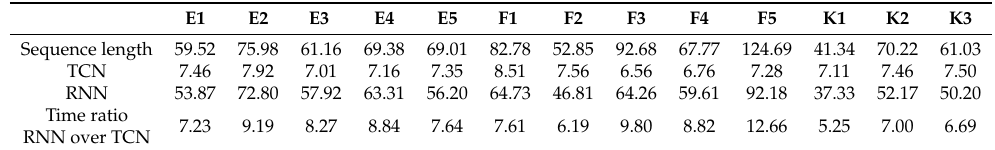
Table 17. Time consumption during an iteration of inference for each algorithm based on Coordinate- A method (unit of time: milliseconds, batch size = 10, measurement by RTX 2080-Ti GPU. E, F, and K denote English, freestyle, and Korean patterns, respectively).